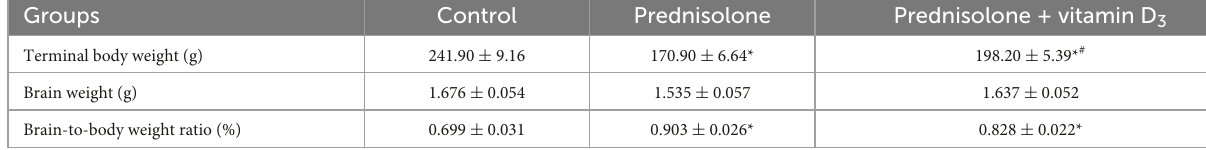
TABLE 1 Effect of prednisolone and vitamin D 3 administration on brain-to-body weight ratios in rats (M ± m, n = 20). Groups